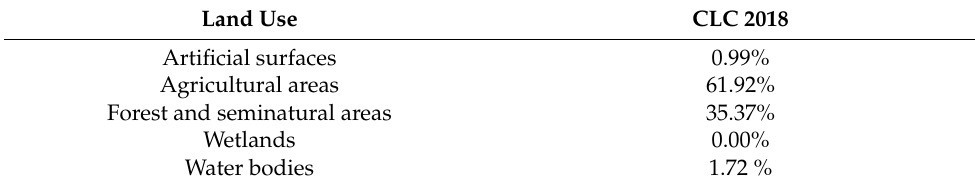
Table 1. Land use areas in Extremadura (Spain)